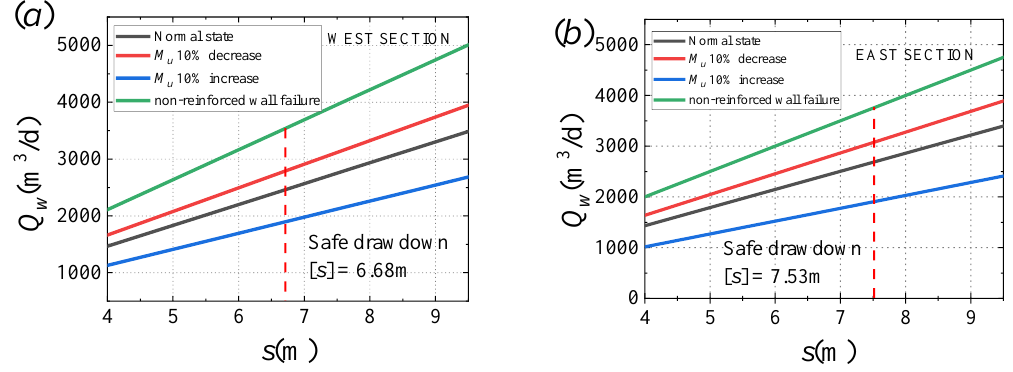
Figure 13. Deviation control curves: ( a ) West section; ( b ) east section.